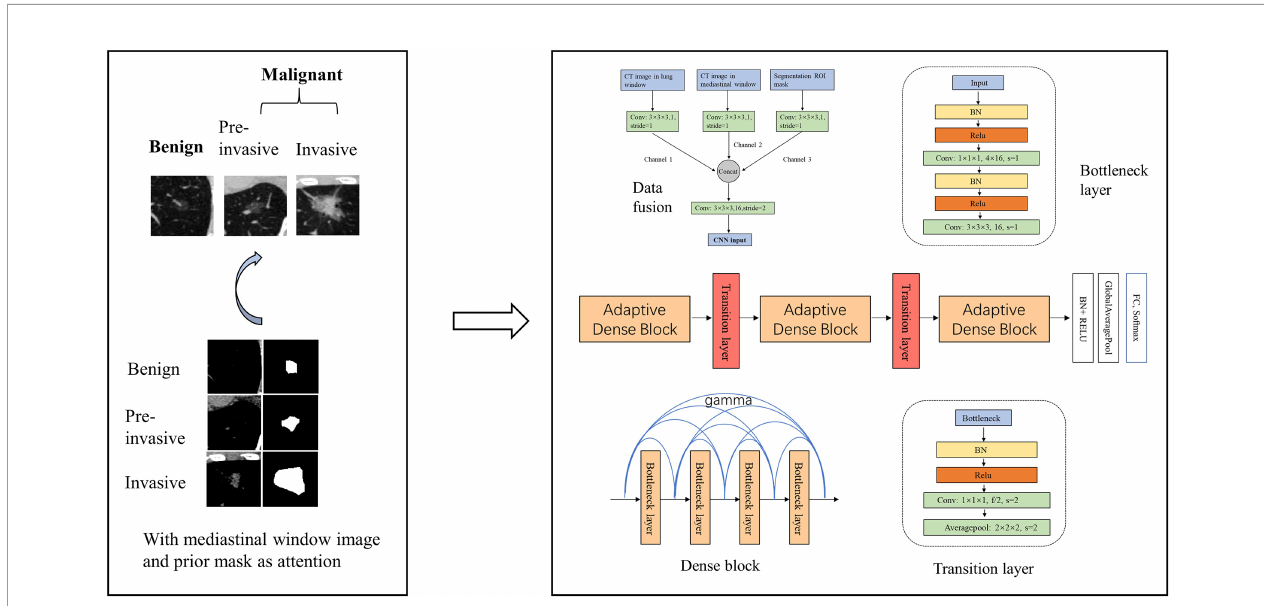
FIGURE 1 | Framework of our model. We developed a 3D CNN model for the malignancy and invasiveness recognition of subsolid pulmonary nodules. The 3D CNN model was based on modi fi ed 3D adaptive DenseNet and was improved by incorporating different window images and segmentation